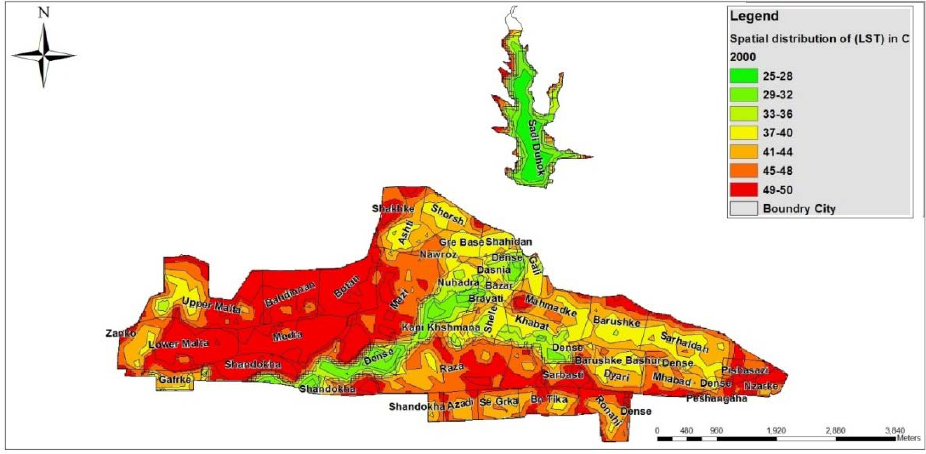
Figure 6. Spatial distribution of land surface temperature (LST) for 2000.